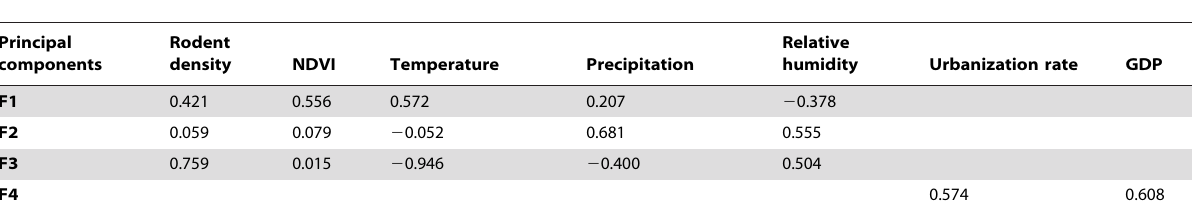
Table 3. Coefficients for the relationship between principal components and variables.